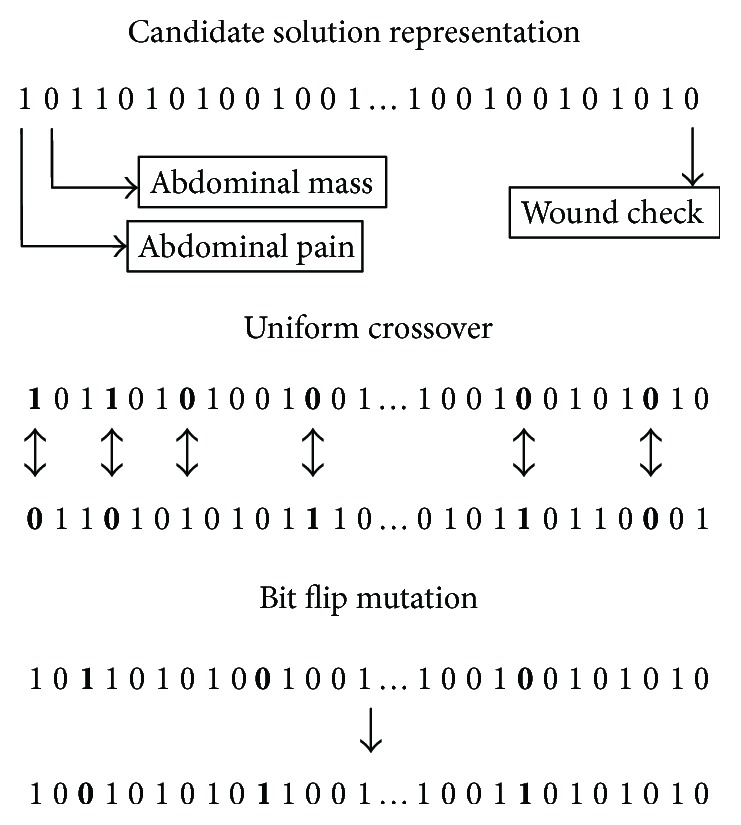
Genetic algorithm representation and recombination operators.